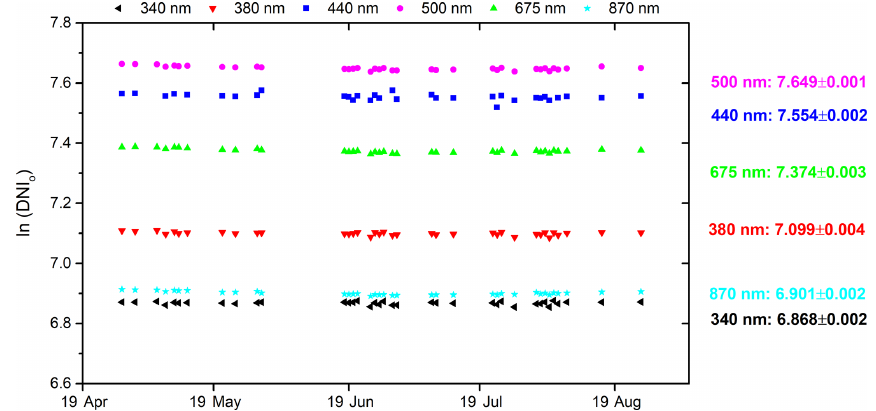
Figure 9. EKO MS-711 DNI o ( λ ) values, and corresponding standard deviations, between April and September 2019 at IZO for all nominal wavelengths measured by the Cimel (340, 380, 440, 500, 675, and 870nm). Table 4. Statistics of the comparison between EKO AOD, with no CSR corrections (CSR Unc.) and implementing CSR corrections (CSR Corr.), and Cimel AOD at 340, 380, 440, 500, 675, and 870nm at IZO between April and September 2019. R – correlation coefficient, slope of the least squares fit between EKO AOD and Cimel AOD; rms – root mean square of the bias; and MB – mean bias. The results of the relative bias are in brackets (in